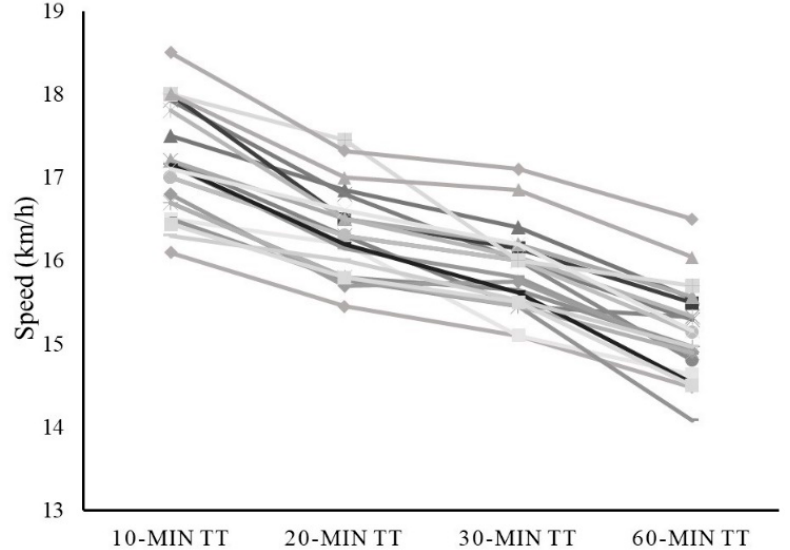
Figure 1. Individual average running speed for each time trial (i.e., 10 min, 20 min, 30 min and 60 min). Each athlete’s speed mean values are represented in a different color line. The level of agreement of power values obtained during running protocols with different durations, as compared to 60-min time trial, was examined (Table 2). For mean power values (W), all the durations (i.e., 10, 20, and 30 min) showed an almost perfect correlation (r > 0.9), whereas the ICC was moderate with data obtained from the 10-min trial (ICC = 0.647), and very large with 20-min and 30-min trials (ICCs = 0.839 and 0.899, respectively). Regarding the normalized mean power values (W/kg), the correlation with data reported during the 60-min trial was very large (r = 0.720 for 10-min trial, 0.868 for 20-min trial and 0.859 for 30-min trial) and the ICCs revealed slight (ICC = 0.188), moderate (ICC = 0.432) and substantial (ICC = 0.625) coefficients for 10-min, 20-min and 30-min time trials, respectively, compared to 60-min protocol. Additionally, the ICF% and CI for each TT were calculated for both MPO and normalized MPO (Table